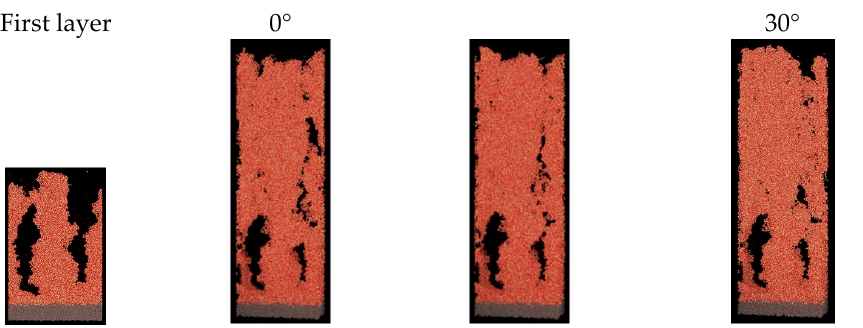
Figure 8. SiO 2 structures, with the same initial first zig-zag layer (left), followed by a layer with a deposition angle of 0°, 30° and 50° with rotating substrate. Graphics generated with NGL [16,17].